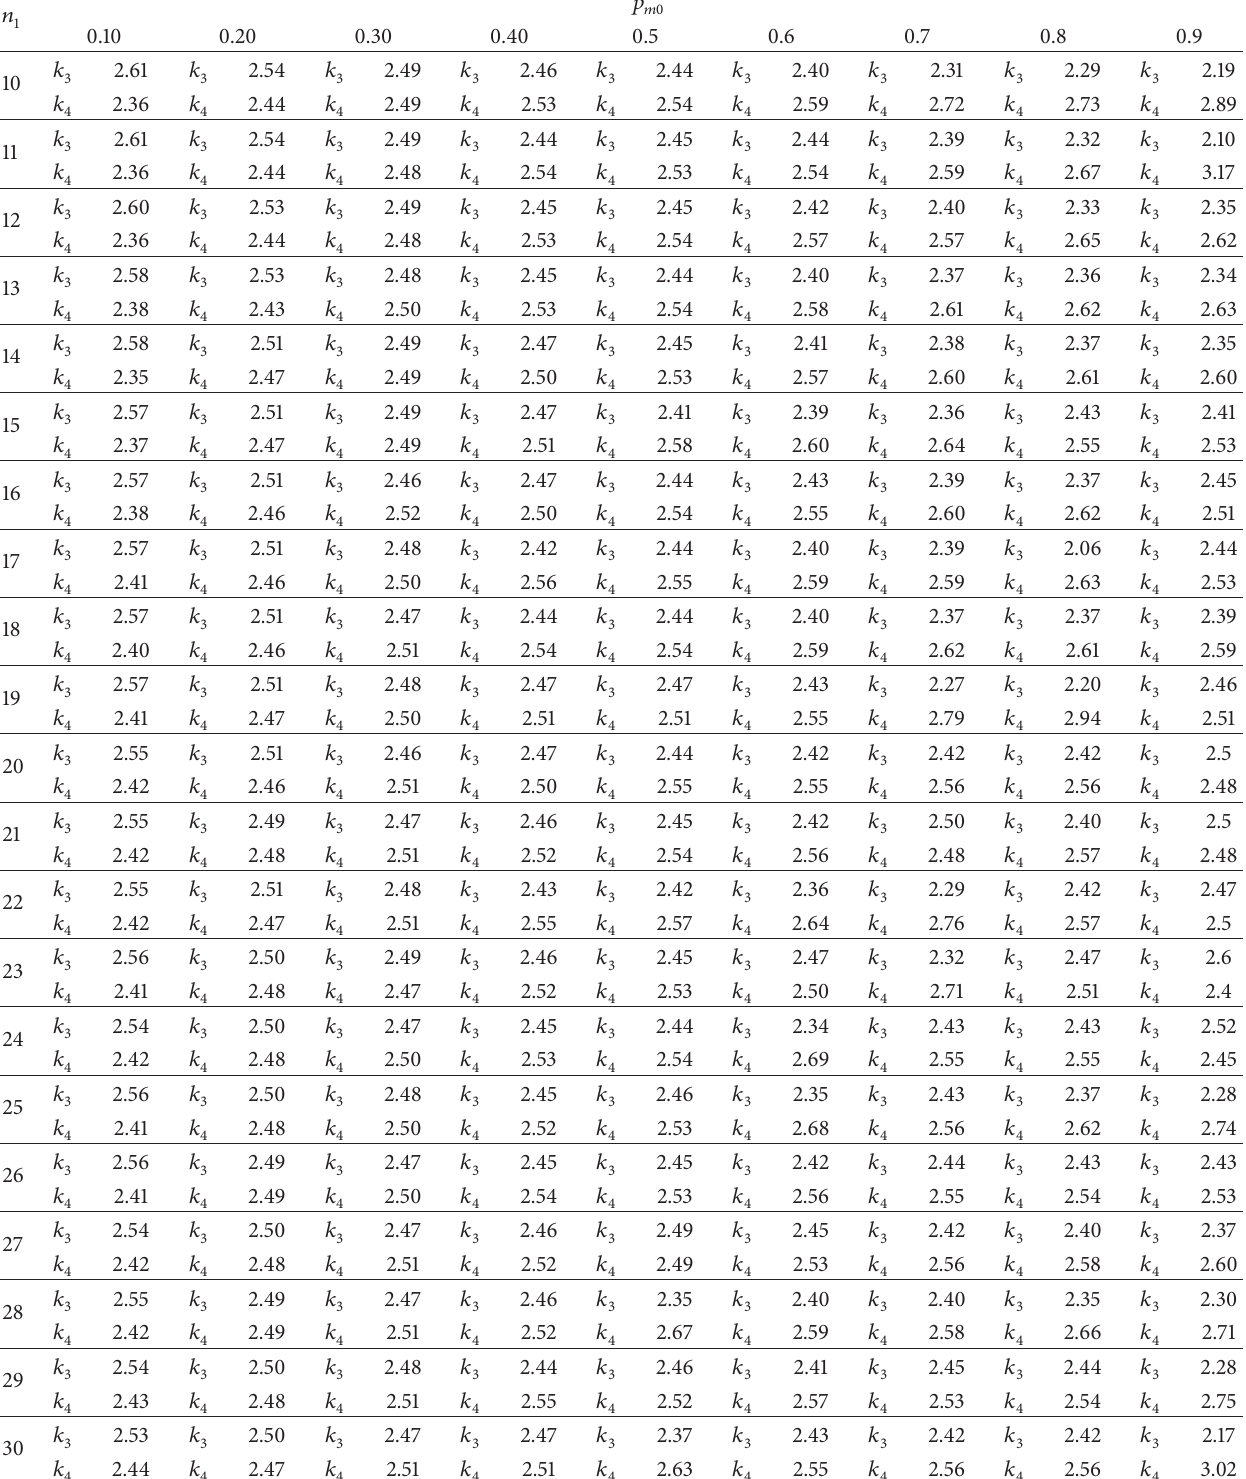
Table 1: The 𝑘 3 and 𝑘 4 with ARL 𝑚0 ≈ 370 for various 𝑛 1 and 𝑝 𝑚0 given 𝜆 1 =